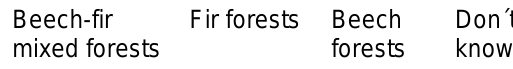
Table A1.1: Interview